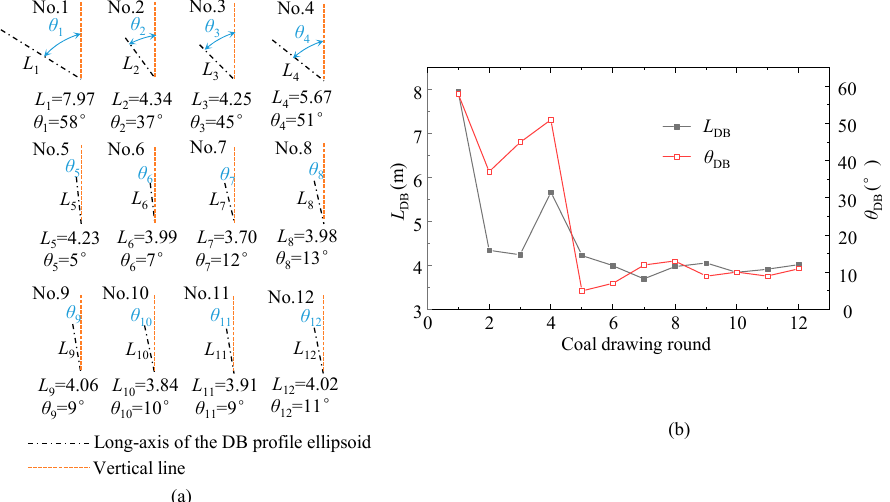
Figure 7. Length ( L DB ) and the included angle ( θ DB ) of long axis of the DB profile ellipsoid. ( a ) Ex- traction of L DB and θ DB ; ( b ) Evolution curves of L DB and θ DB . As shown in Figures 6a and 7, the evolution of L DB and θ DB was consistent with that mentioned above. For the long-axis extension of DB, the intersection point between it and coal floor was located in the goaf after the first four rounds of coal drawing, but it was located at the back of the rear scraper conveyor from the fifth coal drawing round (black dotted line in Figure 7a). For L DB , it reached 7.97 m after the first drawing round and de- creased to around 4.3 m after the second and third drawing rounds, increased slightly after the fourth drawing round, and then gradually decreased before stabilising at around 4 m. For θ DB, it maintained a large deflection (over 45°) during the first four drawing rounds and decreased to around 10° then stabilised from the fifth drawing round. There- fore, a similar conclusion was drawn, suggesting that the fourth drawing round is the key turning point for DBs in the present numerical simulation.